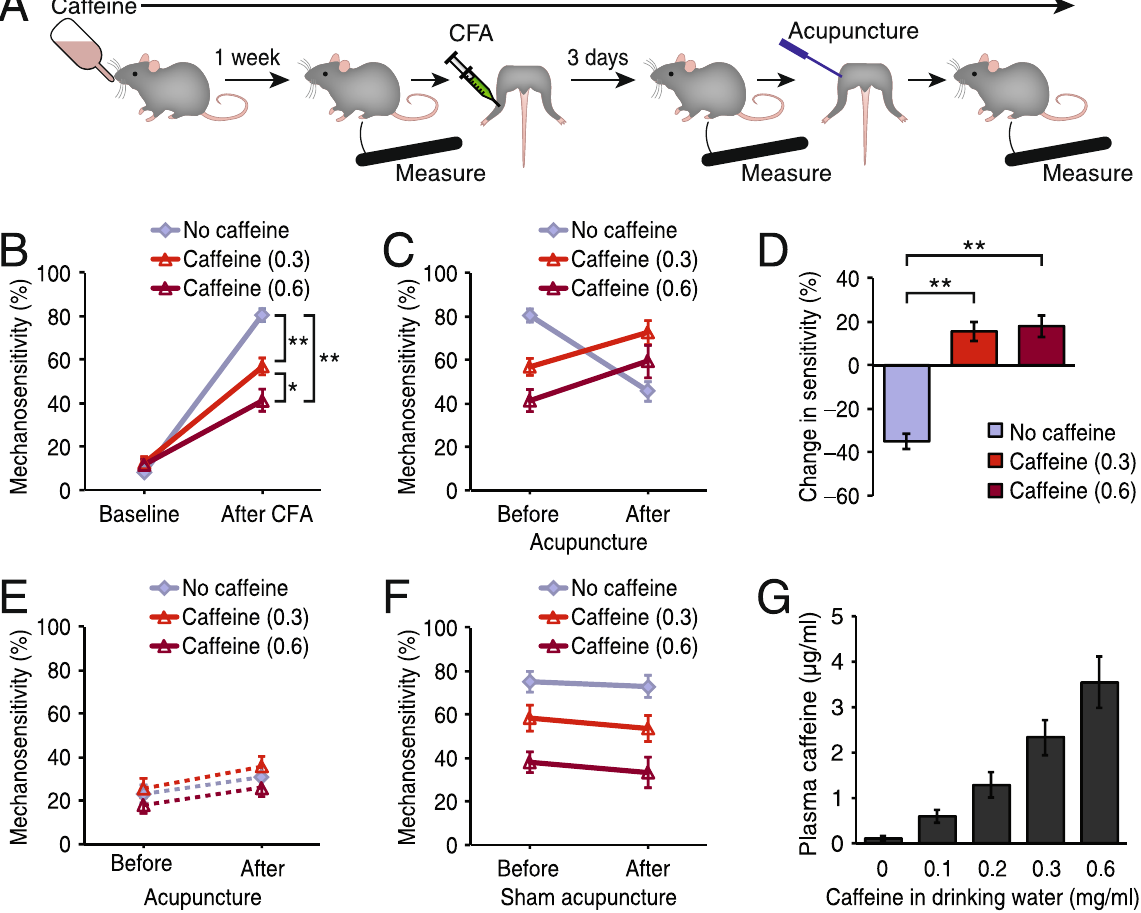
Figure 1. Caffeine interferes with the effect of acupuncture on acute inflammatory pain. ( A ) Schematic diagram outlining the experimental process of caffeine oral administration and behavioral measurements in the acute inflammatory pain model. Mice were acclimated to drinking water containing caffeine for 1 week. Baseline mechanical sensitivity was measured using von Frey filament, then pain was induced by administration of complete Freund’s adjuvant (CFA) in the ankle joint. Three days later, mechanical hypersensitivity was measured before an acupuncture treatment was given to the affected hind leg, followed by another measurement to obtain the changes in mechanical sensitivity by acupuncture treatment with or without caffeine administration. ( B ) Pain induction by CFA under caffeine consumption. Mice receiving normal drinking water (No caffeine, blue grey) showed prominent mechanosensitivity 3 days after CFA administration. Mice treated with the drinking water containing caffeine at the doses of 0.3 mg/ml (red) and 0.6 mg/ml (dark red) also exhibited pain behavior, but with lower intensity compared to the no caffeine group. N = 15–16; * p < 0.05, ** p < 0.01. ( C ) Mechanical sensitivity before and after acupuncture treatment. Mice with normal drinking water showed a reduction of sensitivity after acupuncture treatment. However, the same acupuncture treatment failed to reduce pain in mice receiving the drinking water supplemented with caffeine (0.3 and 0.6 mg/ml). N = 15–16. ( D ) Summary histogram comparing the changes in mechanical sensitivity by acupuncture amongst three groups that are shown in panel C. In the no caffeine group, acupuncture reduced pain, but the effect was reversed when the mice were administered caffeine. ** p < 0.01. ( E ) Mechanical sensitivity in the contralateral leg to the inflammation. In the contralateral leg, no pain was induced by CFA. Acupuncture to the ipsilateral leg did not significantly alter the mechanical sensitivity of the contralateral leg (p = 0.94). ( F ) Mechanical sensitivity before and after sham acupuncture treatment. All three groups (No caffeine, 0.3 and 0.6 mg/ml of caffeine groups) showed no reductions in sensitivity following sham acupuncture treatment. N = 14–16. ( G ) Caffeine in mouse plasma. The average caffeine concentration in the plasma increased corresponding to the caffeine concentration in the drinking water. N = 16–21. Displayed are means ± S.E.M. in B – G